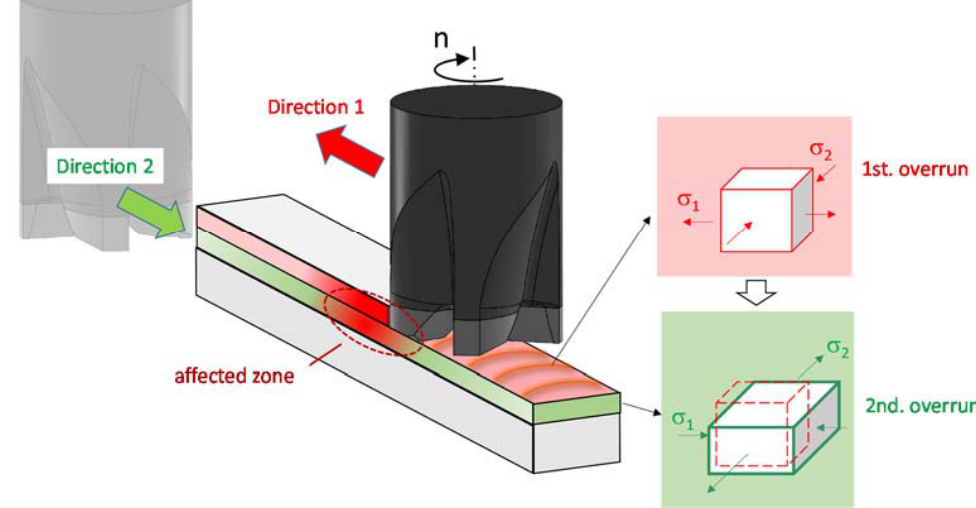
Figure 1. Schematic representation of the milling with two overruns with the changeable directions.